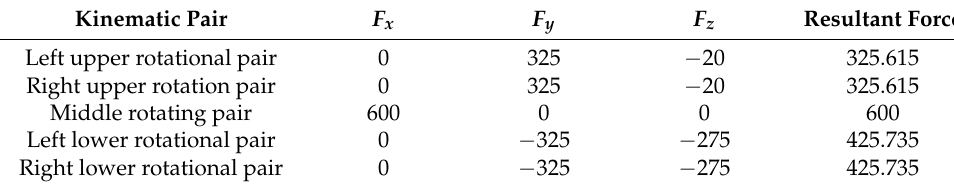
Table 3. Force on moving pair of rear wheel connector (N).